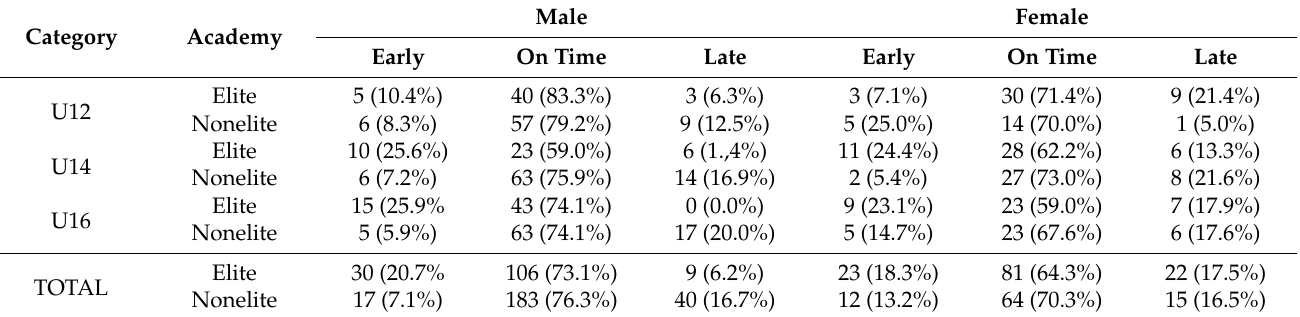
Table 4. Maturity status in the different elite and nonelite academies, differentiating between